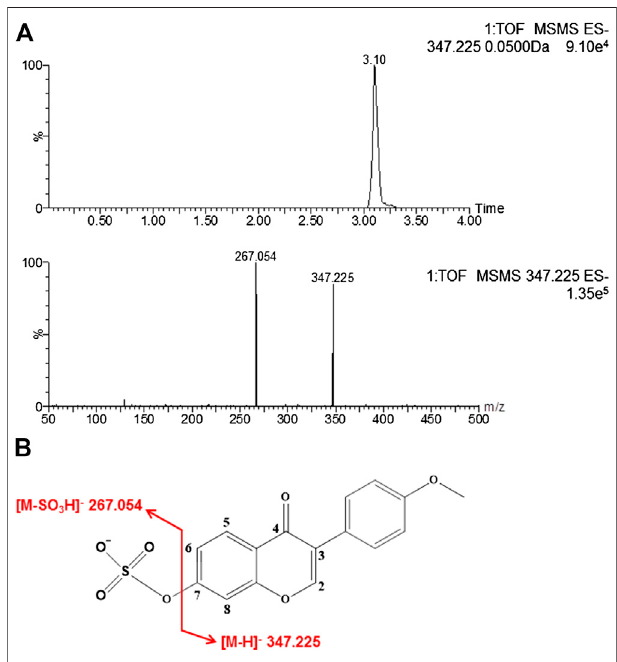
FIGURE 1 | The chromatogram of formononetin sulfate under MS/MS scanning (A) and the fragmentation pathways of formononetin sulfate (B) .